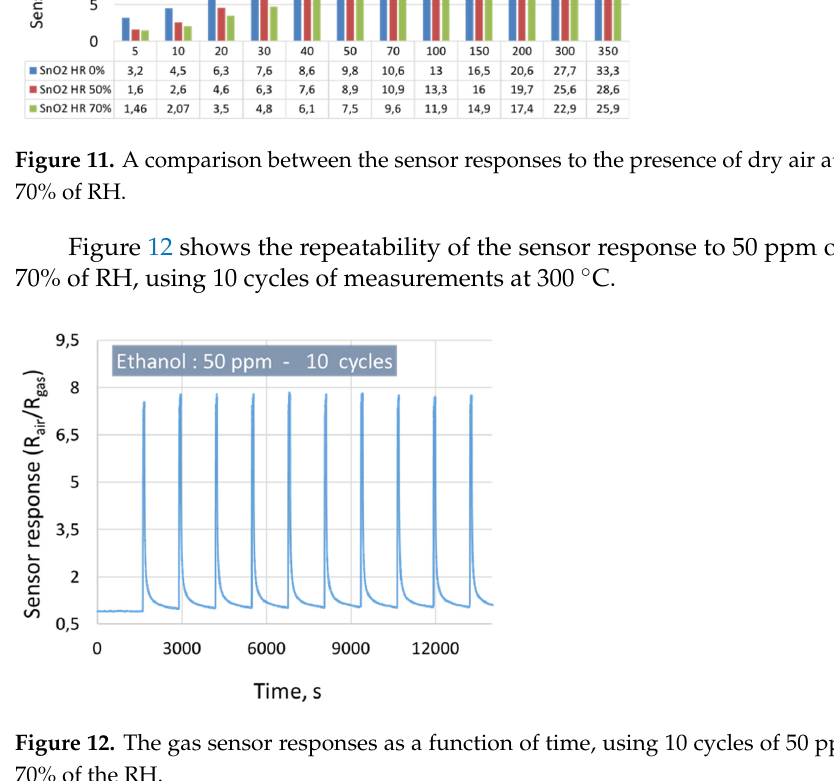
Figure 12 . The gas sensor responses as a function of time, using 10 cycles of 50 ppm of ethanol at 70% of the RH.